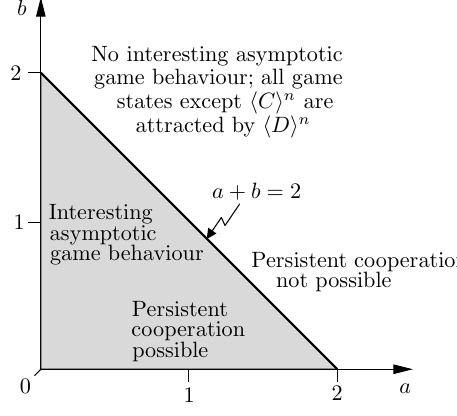
Figure 8: The parameter space of the ESPD on a